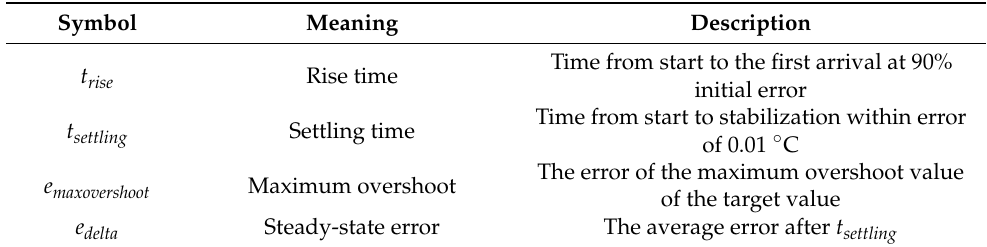
Table 4. Symbol’s description of PID control performance.